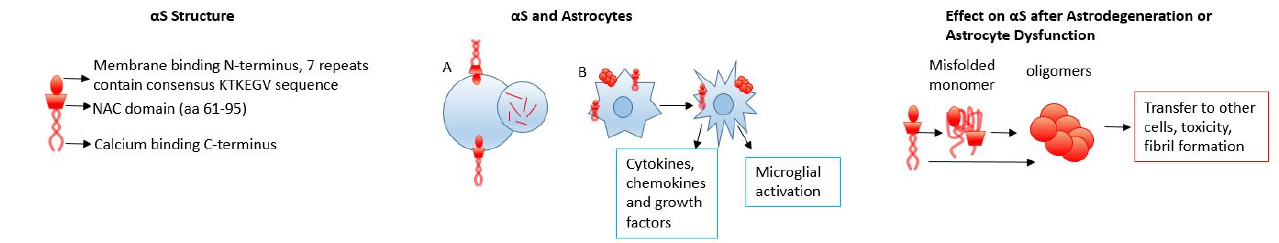
Figure 1. α S’s structure consists of an amphipathic membrane-binding N-terminus sequence that contains 7 repeats with the consensus KTKEGV sequence, a non-amyloid- β component (NAC) domain responsible for its aggregation potential, and a calcium binding C-terminus. In A, the astrocyte can degrade α S monomers and oligomers through the endolysosomal pathway. In B, interaction with α S monomers and oligomers can cause astrocyte reactivity resulting in the release of cytokines, chemokines and growth factors, and cause microglial activation, although the level of monomeric α S to induce broad effects is uncertain. In the event of astrodegeneration or astrocyte dysfunction, α S can misfold, aggregate and spread from cell to cell, causing toxic fibril formation, which can also then cause native α S to misfold as